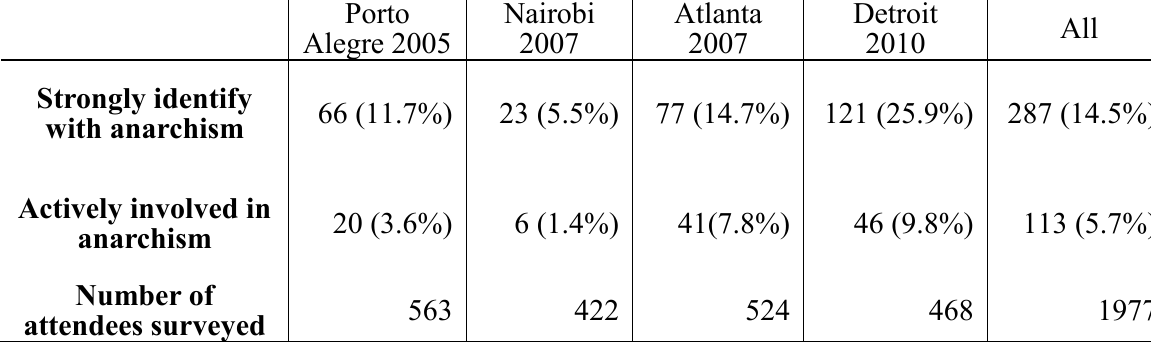
Table 1: Anarchist Identification and Activism at the Social